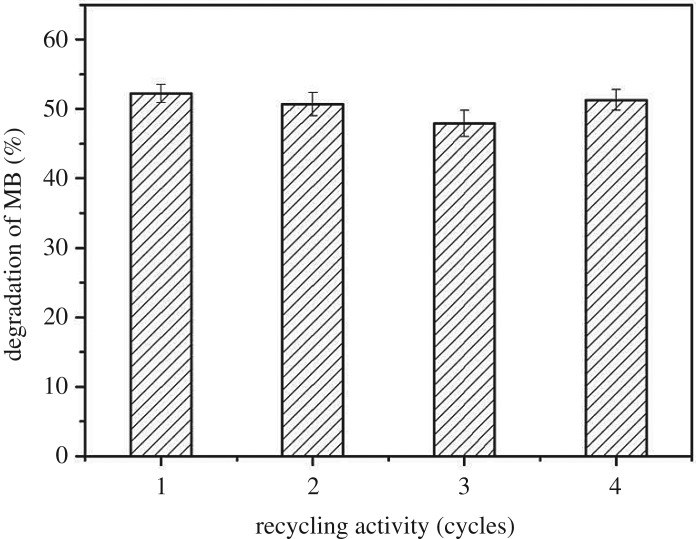
The photocatalytic activity of 1.0%Tb–TiO2 at different periodic cycles.